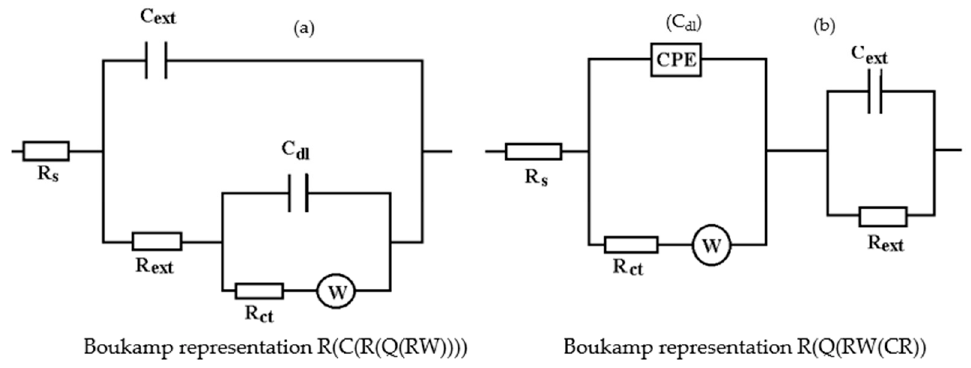
Figure 16. The equivalent circuits used to model EIS data in samples immersed in seawater for ( a ) 36 days or ( b ) 78 days.